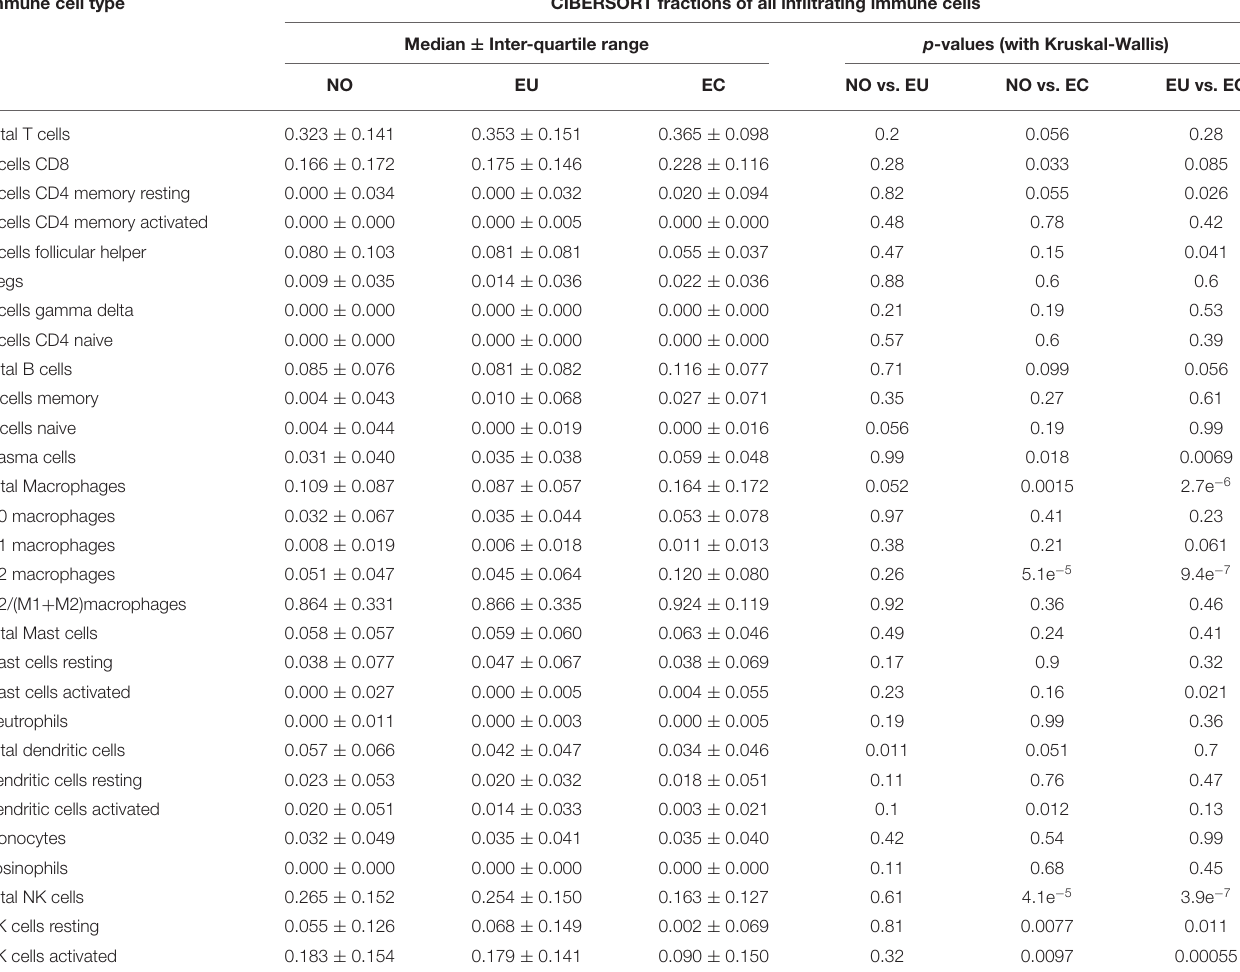
TABLE 2 | Comparison of CIBERSORT immune cell fractions between ectopic endometrial tissue (EC), eutopic endometrial tissue (EU), and normal endometrial tissues (NO). Immune cell